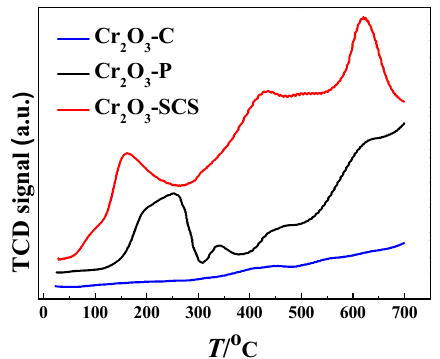
Figure 6. The profiles for temperature-programmed desorption of ammonia (NH 3 -TPD) for Cr 2 O 3 catalysts prepared by different methods.